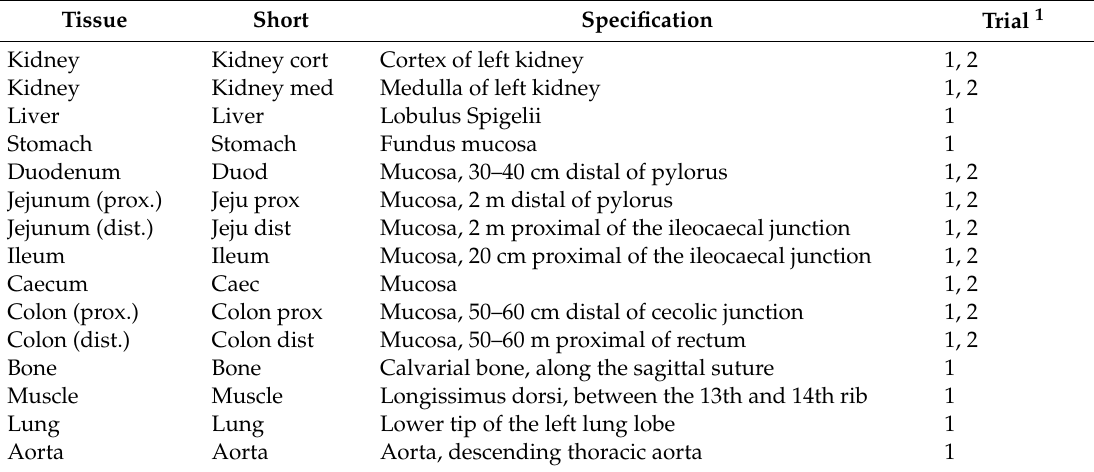
Table 2. Tissue samples and their specifications taken for both